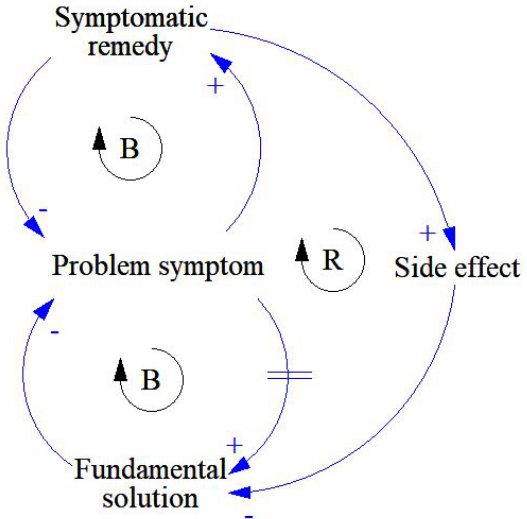
Figure 3. The Causal Loop Diagram (CLD) of the “shifting the burden” systems archetype. In this particular setting, addressing the problem symptom using a quick fix rather than a fundamental measure will cause increasing dependence on symptomatic fixes. “B” refers to a balancing loop and R refers to a reinforcing loop. Double bars reflect lag time.